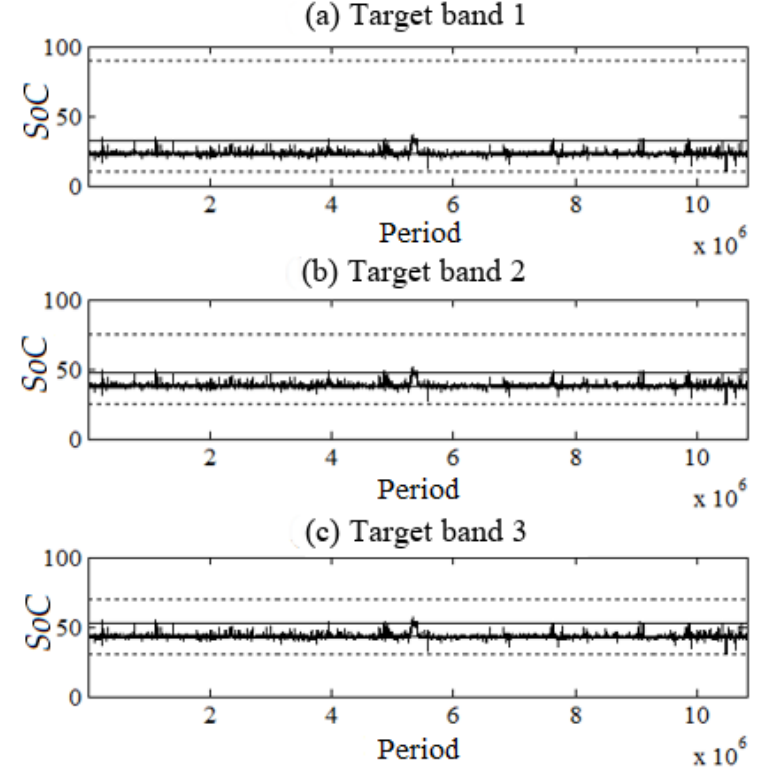
Figure 9. SoC trajectories for different SoC target bands. ( a ) [ 25.2%, 30.2% ] ; ( b ) [ 40.2%, 45.2% ] ; ( c ) [ 45.2%, 50.2% ]